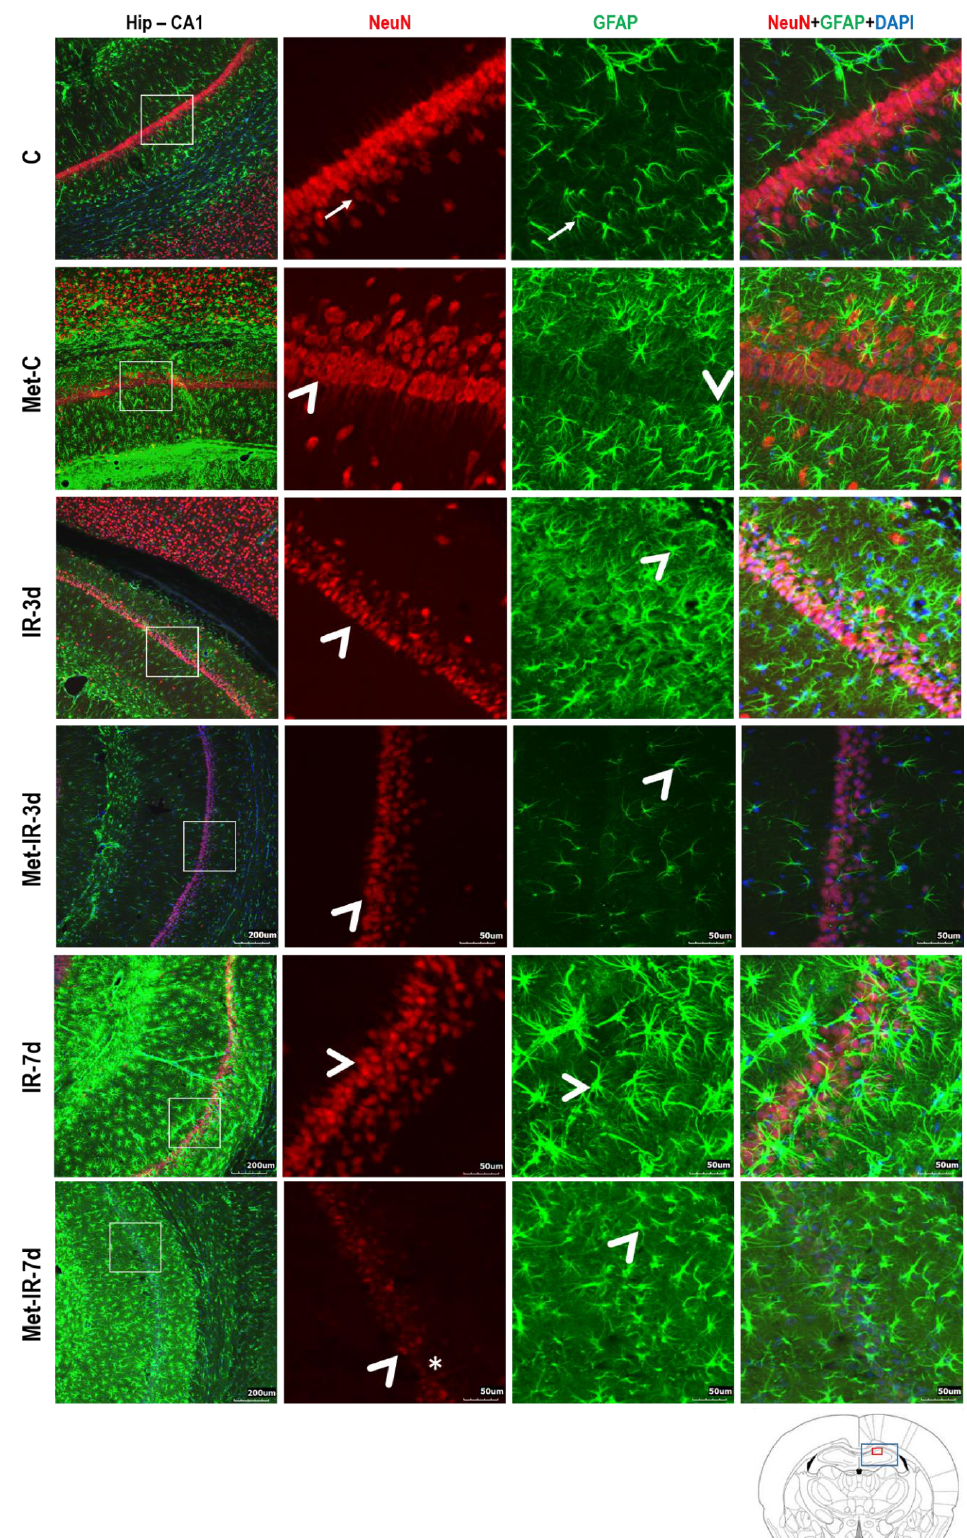
Figure 4. Immunofluorescent microphotographs of NeuN (red) and glial fibrillary acidic protein (GFAP, green) in the CA1 region of the hippocampus. Fluorescent micrographs of rat hippocampus representing controls, animals 3 or 7 days post-ischemia with / without Met diet pre-treatment. The